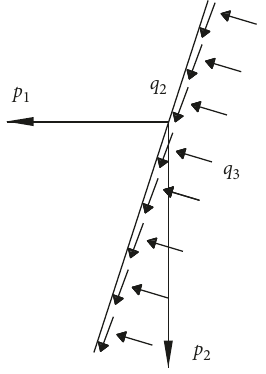
Figure 4: .Vector composition of external forces P